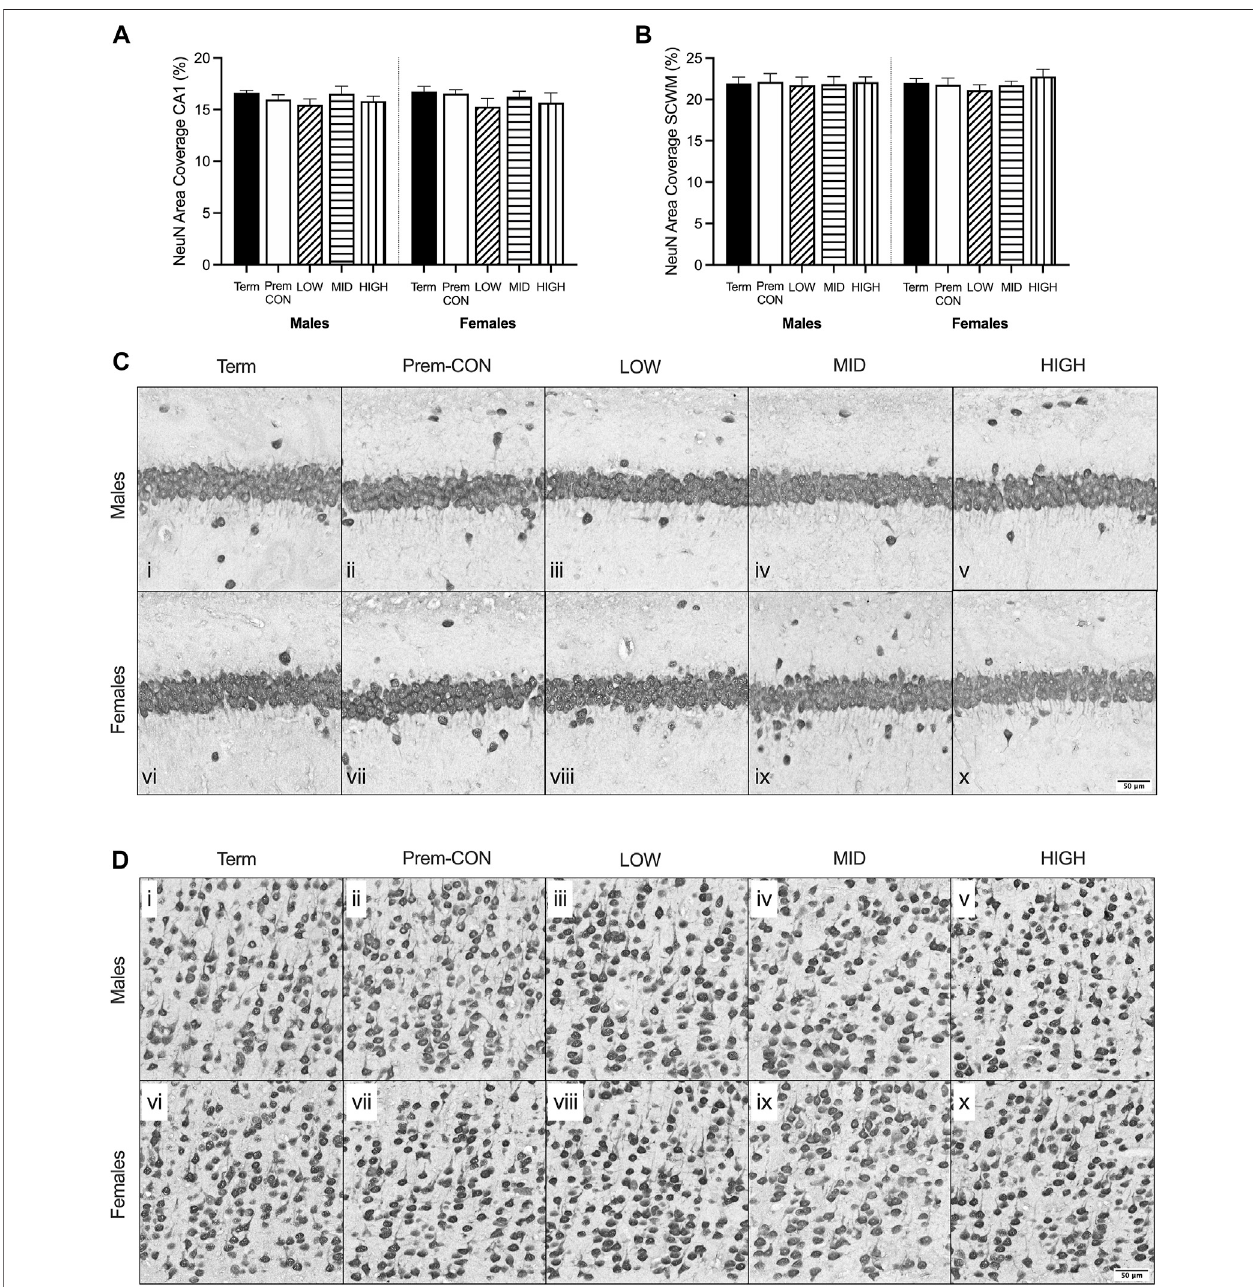
FIGURE3| Neuronalnuclei(NeuN) immunostaining wasquanti fi edinthebrainofterm control(black;males n =8,females n =8),preterm control(white;males n = 6, females n = 7), low-GNX (diagonal stripes; males n = 6, females n = 5), mid-GNX (horizontal stripes; males n = 6, females n = 5), and high-GNX (vertical stripes; males n = 6, females n = 5) for (A) the CA1 region of the hippocampus and (B) the overlying subcortical white matter. Data presented as means ± SEM with * indicating signi fi cance at p < 0.05. (C) Representative photomicrographs of NeuN immunostaining of the (C) CA1 region and (D) overlying subcortical white matter (i, vi = term; ii, vii = preterm control; iii, viii = low-GNX preterm; iv, ix = mid-GNX preterm; v, x = high-GNX preterm). Scale bar = 50 μ m.